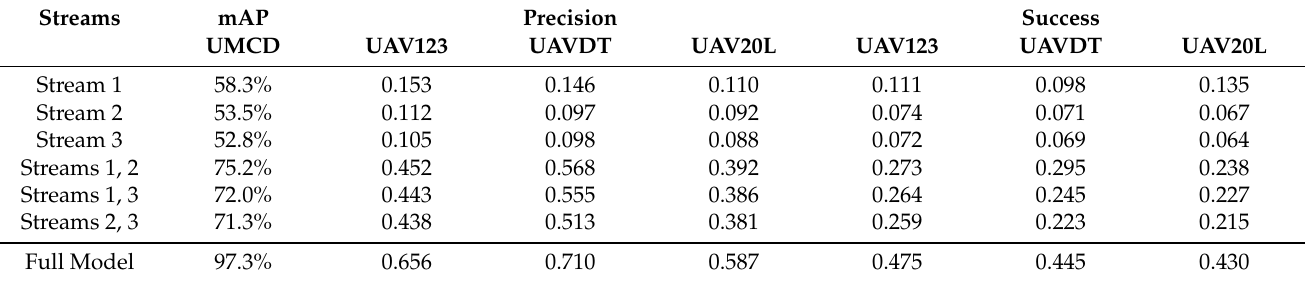
Table 2. Summarization of the results obtained in the ablation